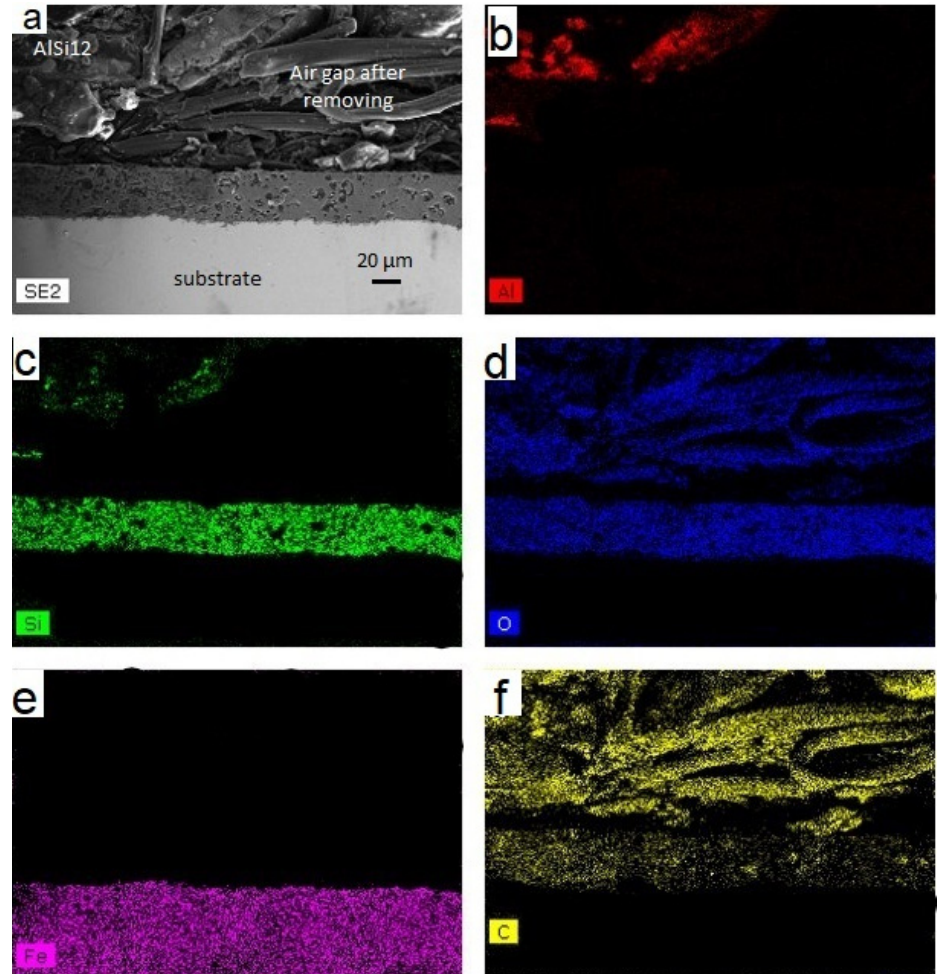
Figure 8. ( a )Cross-sectional SEM observation of the protective layer coated on the 304L substrate after 1200 h at 700 °C in AlSi 12 (300 × magnification) and EDS analysis of Al ( b ), Si ( c ), O ( d ), Fe ( e ), and C ( f ).